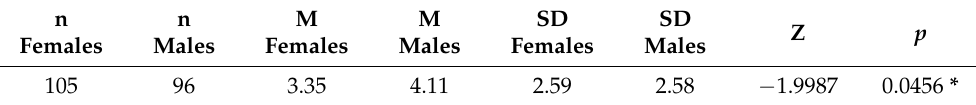
Table 5. Mann-Whitney U test of the Fagerstrom questionnaire in female and male smokers. n n M Females Males Females